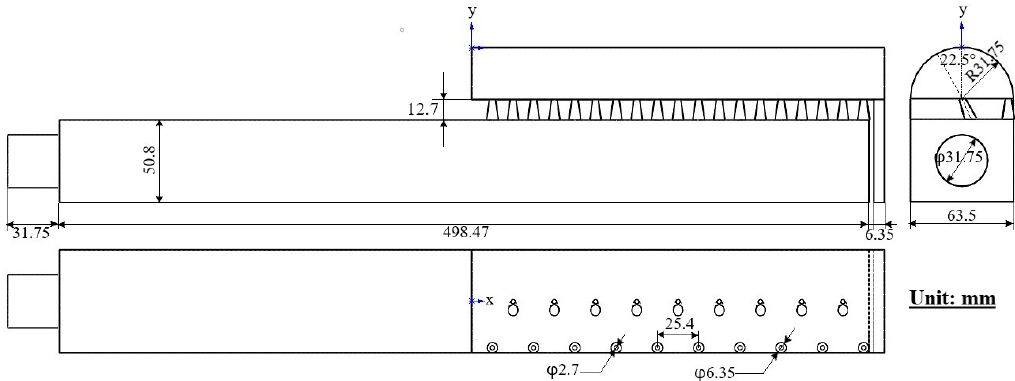
Figure 2. Dimensions detail of the compound cooling unit.